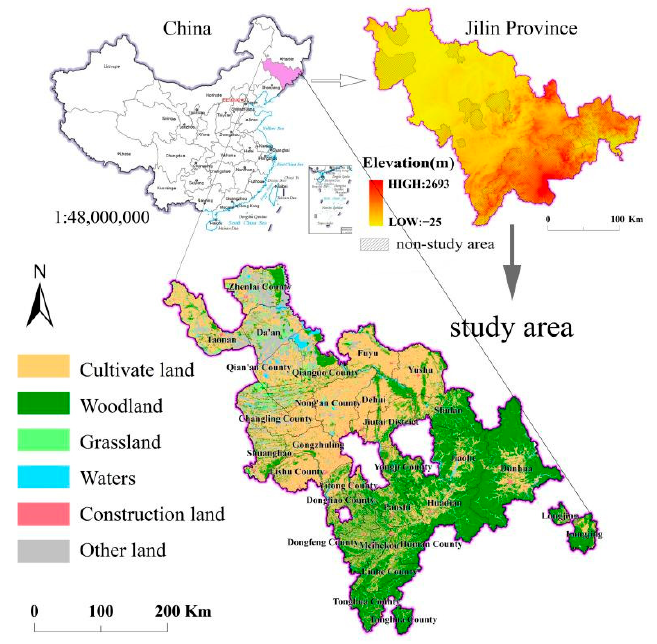
Figure 1. The location and main land types in the black-soil breadbaskets in Jilin Province, Northeast China (The map of China in the figure is produced under the supervision of the Ministry of Natural Resources of the People’s Republic of China, drawing number: GS (2019) No. 1673).